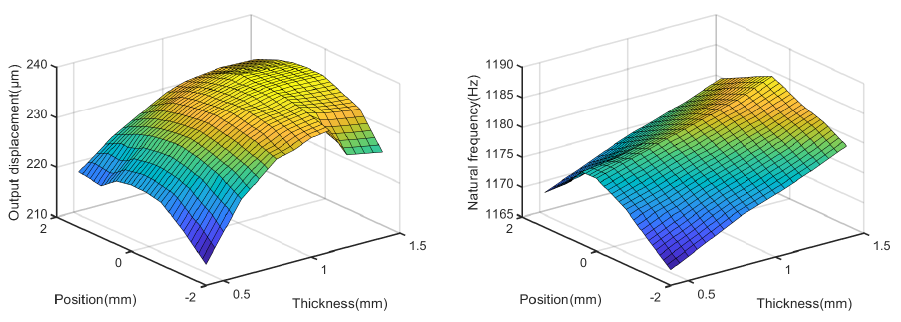
Figure 9. Effects of t b and l 1 on the output displacement and natural frequency.